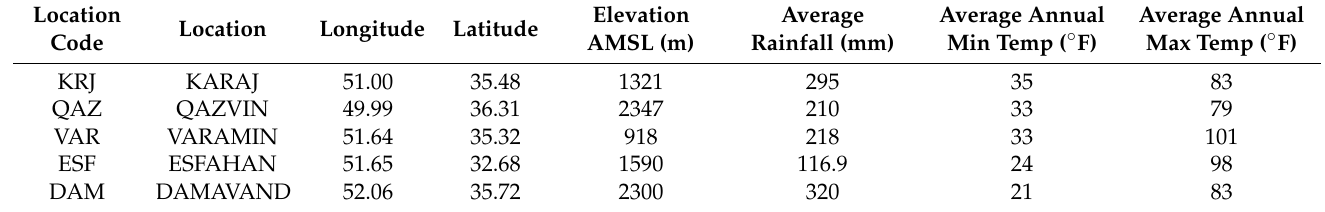
Table 2. Annual rainfall mean, codes, and geographical parameters for the